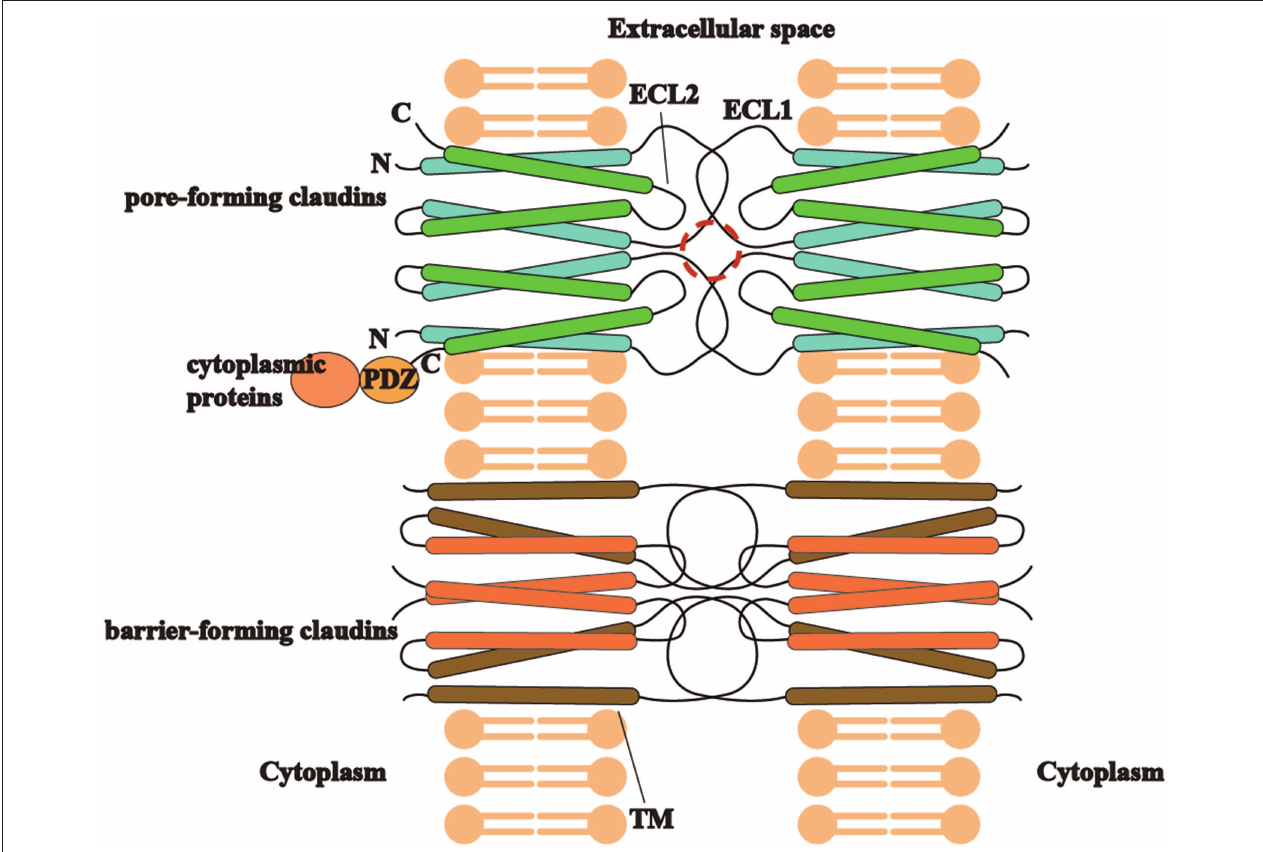
FIGURE 2 | The trait of claudins (pore-forming or barrier-forming) depends on pore-like structures (marked in red circle) and polar amino acid residues of ECLs and occasionally TM segments in claudin dimers interaction. C-terminus of different claudins is diverse and able to bind cytoplasmic proteins by PDZ domain, which may be the structural foundation for claudins to modulate cell behaviors as signaling